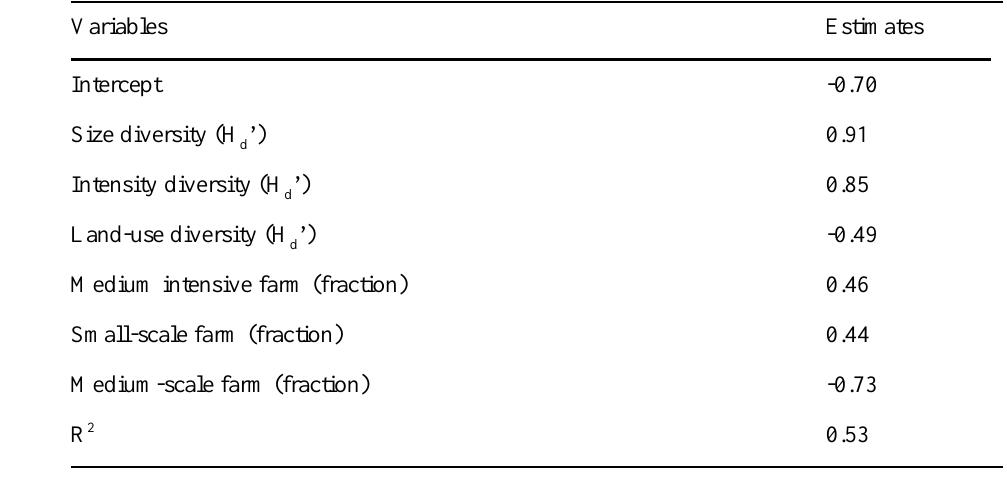
Table 2 . Results from the regression model with r(yield, temp) as dependent variable and farm diversity and composition and prevailing climate conditions as independent variables (see text for further